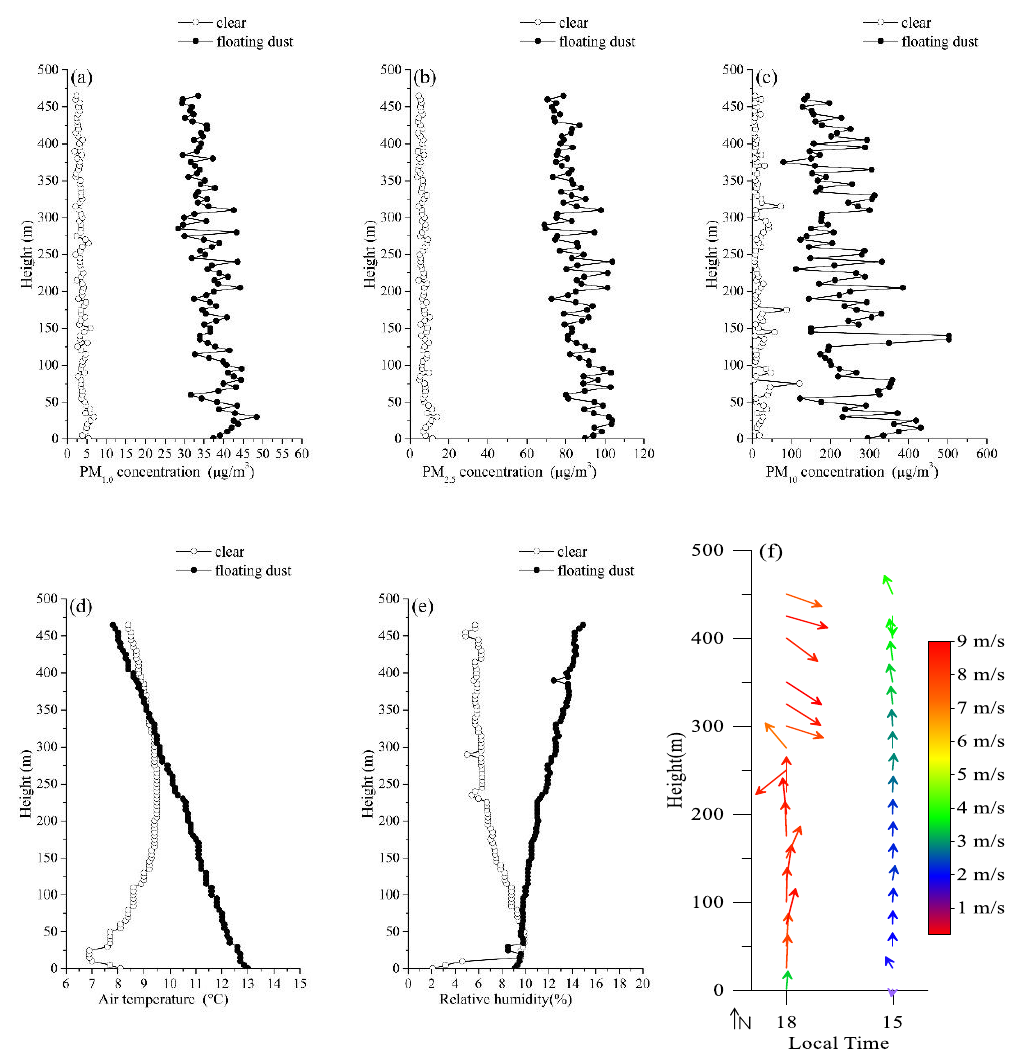
Figure 13. Vertical profiles of the PM concentrations ( a : PM 1.0 , b : PM 2.5 , and c : PM 10 ) and the related meteorological parameters ( d : air temperature, e : relative humidity, and f : vector wind) in the boundary layer during a clear period (18:00 local time, 14 November) and a floating dust period (15:00 local time, 13 November) at Xiaotang.